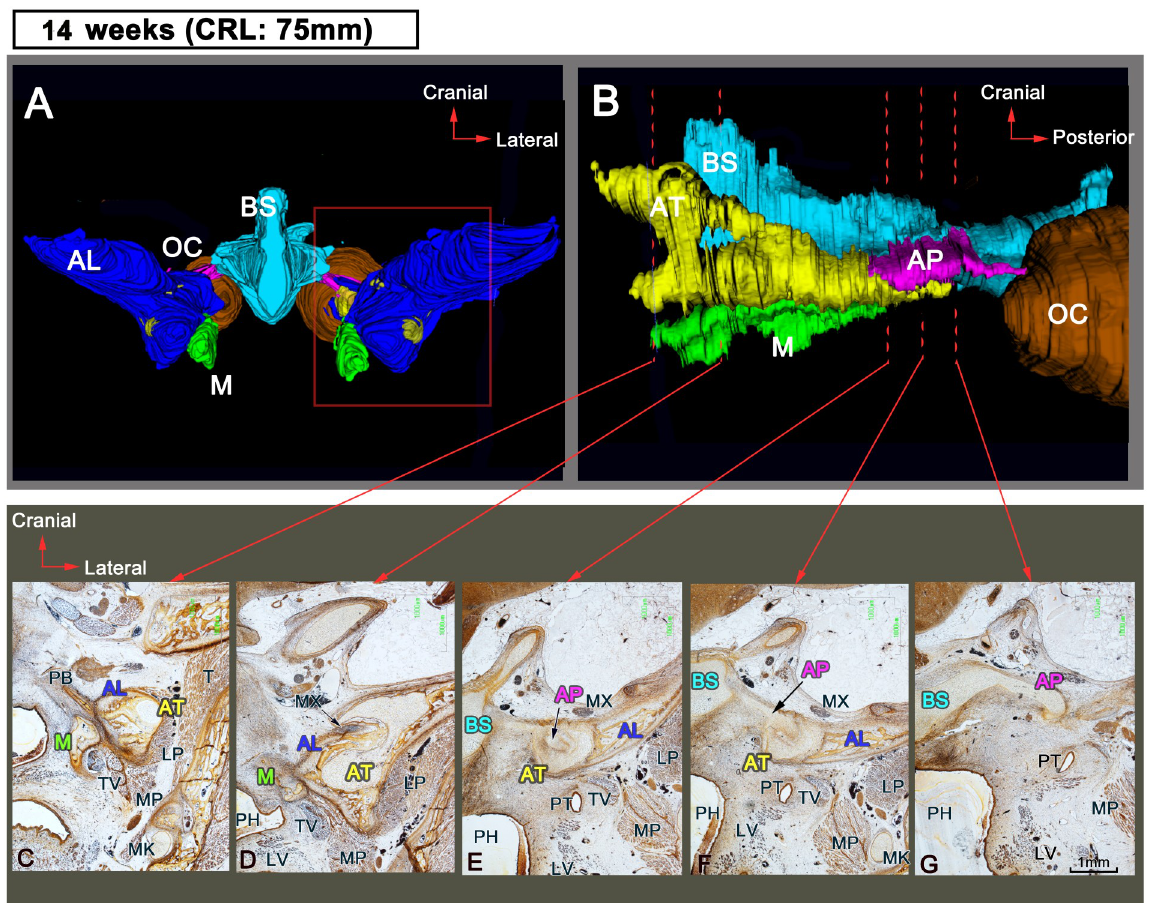
Fig 3. Sphenoid development at 14 WD. (A and B) 3D reconstructions and (C–G) frontal sections. (A) Anterior view and (B) lateral view. (C– G) are obtained at the same magnification. Color code: blue, BS; pink, AP; yellow, AT; green, M; orange, OC; dark blue, AL (membranous bones). AL, alisphenoid; AP, alar process; AT, ala temporalis; BS, basisphenoid; LP, lateral pterygoid muscle; LV, levator veli palatini; M, medial pterygoid process; MK, Meckel’s cartilage; MX, maxillary nerve; OC, otic capsule; PB, palatine bone; PH, primitive pharynx; PT, pharyngotympanic tube; T, temporalis muscle or temporal bone; TV, tensor veli palatine; WD, weeks of development.